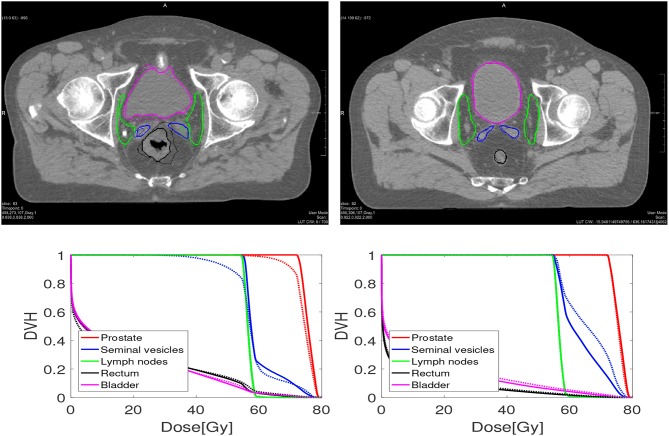
An example of one case (Left) where the dosimetric criteria was met for elastix, and one case (Right) where not. The bottom figures are dose volume histograms. The solid line represents the manual contouring results while the dotted line is the automatically propagated one with the setting of 100 iterations. For the prostate (left and right), the MSD is 2.26 and 1.12 mm, while V95% is 90.8% and 99.8%, respectively. For the seminal vesicles (Left, Right), the MSD is 2.74 and 1.00 mm, while V95% is 88% and 100%, respectively. For the lymph nodes (Left, Right), the MSD is 1.45 and 0.99 mm, respectively, while V95% both are 100%.